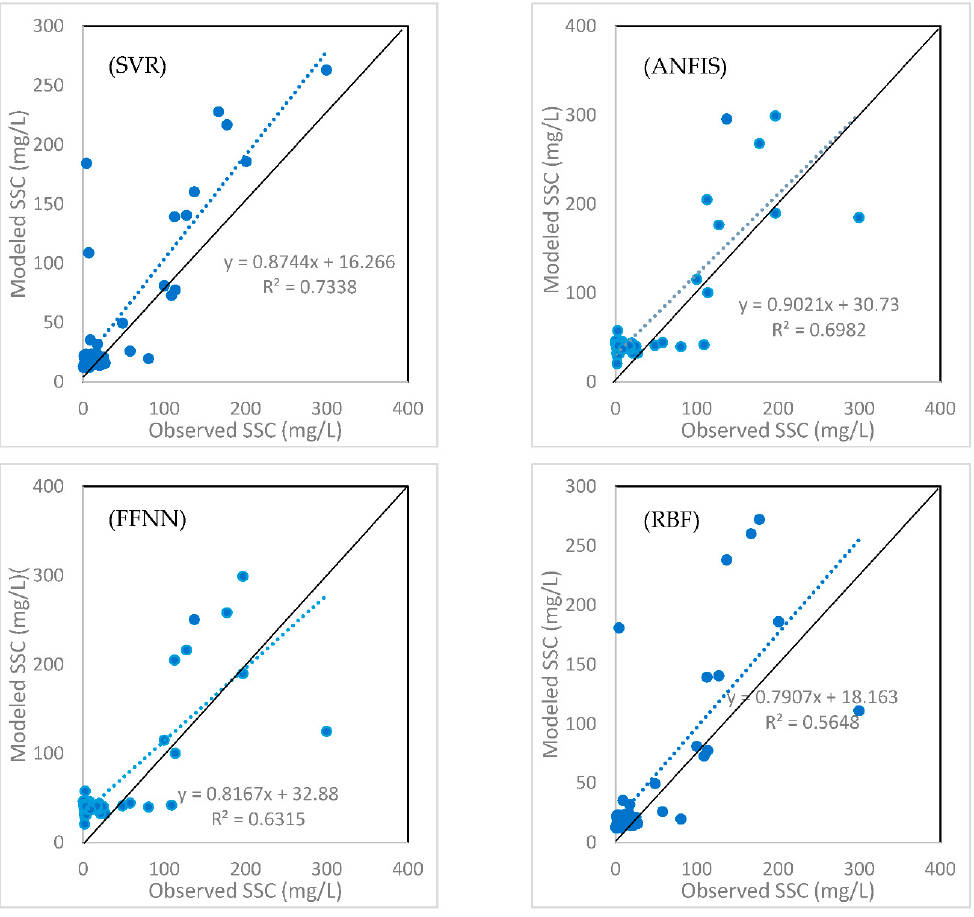
Figure 4. Scatter plots of the observed and estimated SSC based on the best input scenario during test phase for SVR, ANFIS, FFNN, and RBF models.